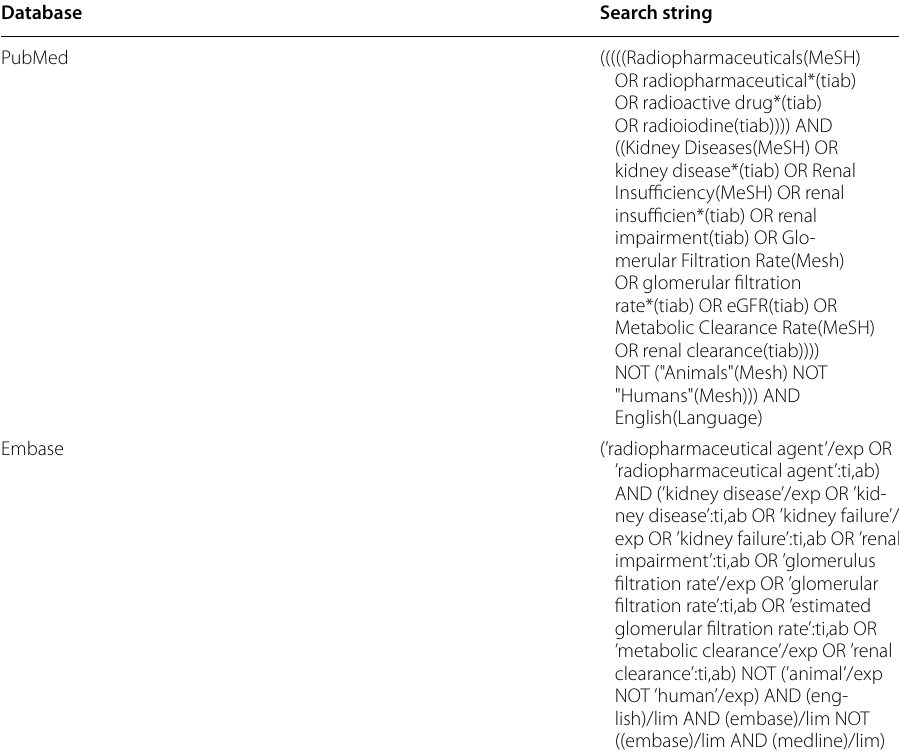
Table 1 Search strategies employed for PubMed and Embase